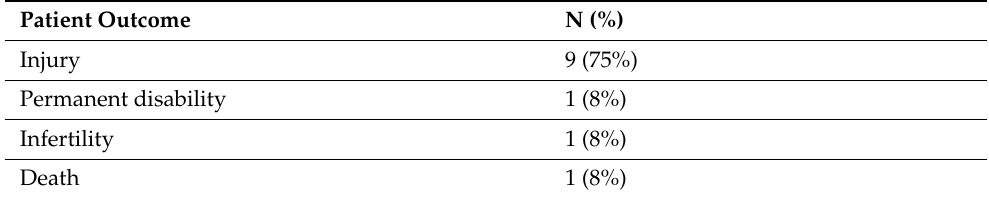
Table 2. Characteristics of 12 legal cases involving trainees in